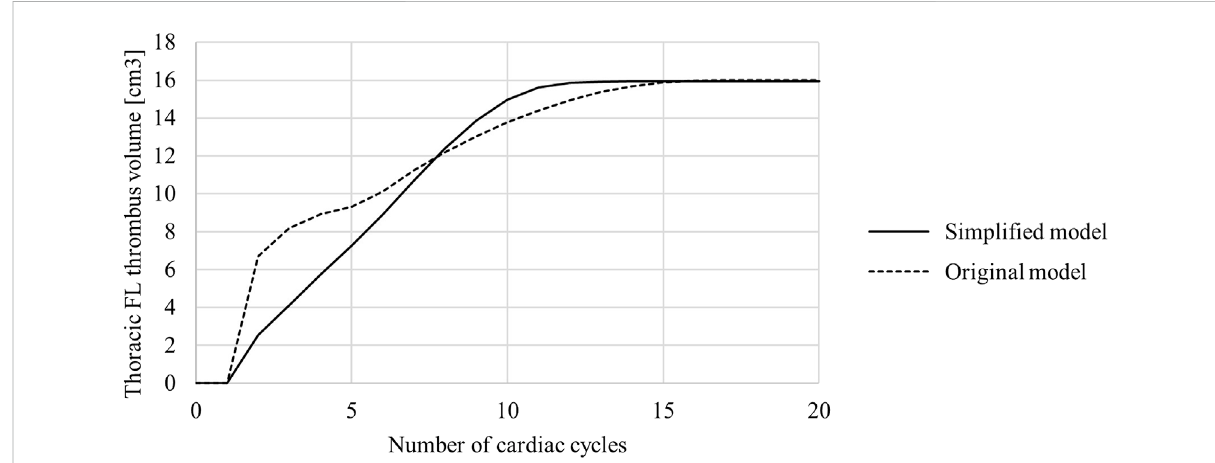
FIGURE 6 Thoracic false lumen (FL) thrombus volume in the original and simpli fi ed model. Volume was measured at the end of each cardiac